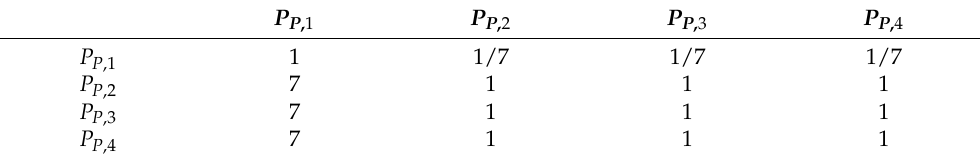
Table 9. Judgment matrix in the indicator layer ( P P ,1 – P P ,4 ).